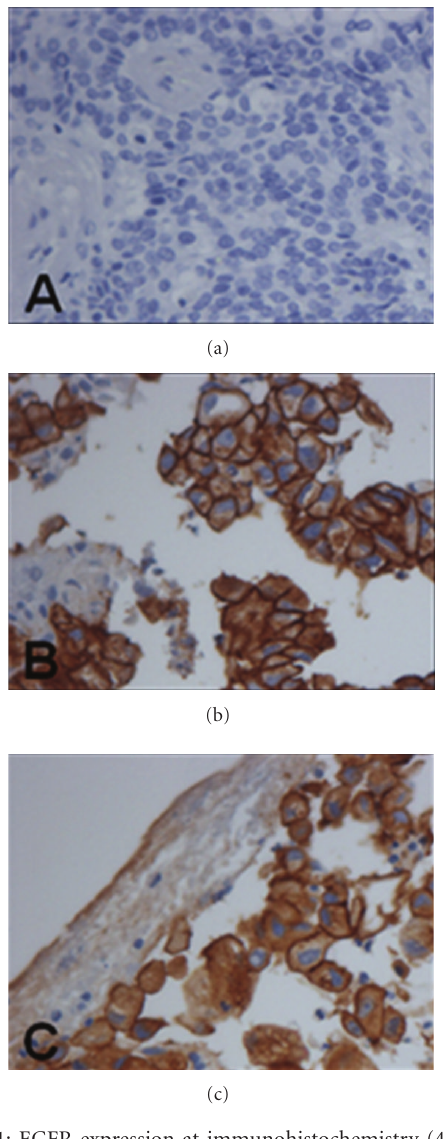
Figure 1: EGFR expression at immunohistochemistry (400X). In (a), a case of adenocarcinoma with negative EGFR. In (b) and (c), 2 di ff erent cases of adenocarcinoma with positive EGFR (brown staining).